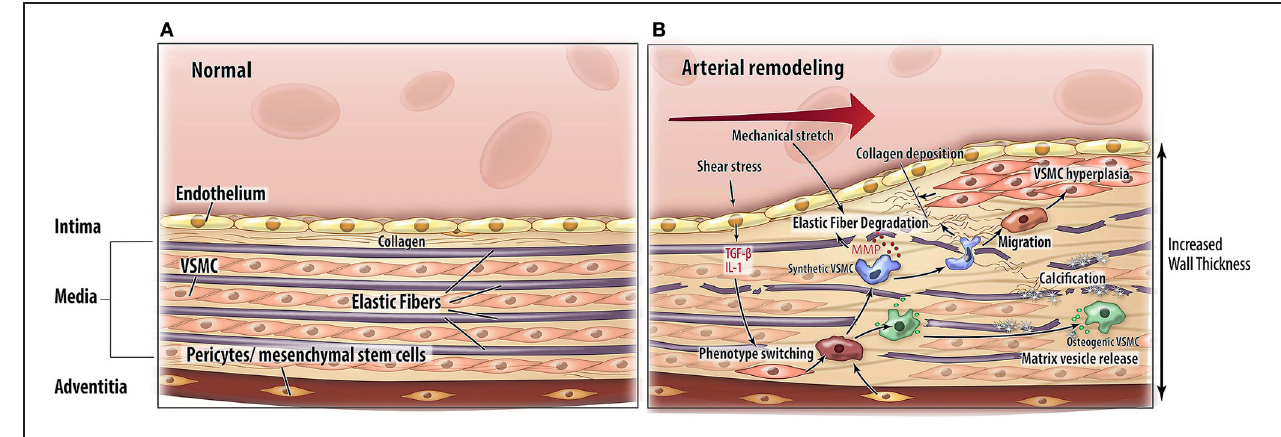
calcification and collagen deposition lead to adaptation of the vascular wall. Abbreviations: TGF- β , transforming growth factor-beta; IL-1,